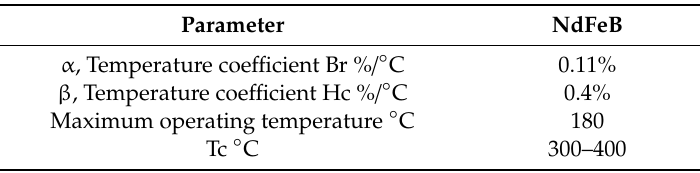
Table 5. NdFeB temperature related